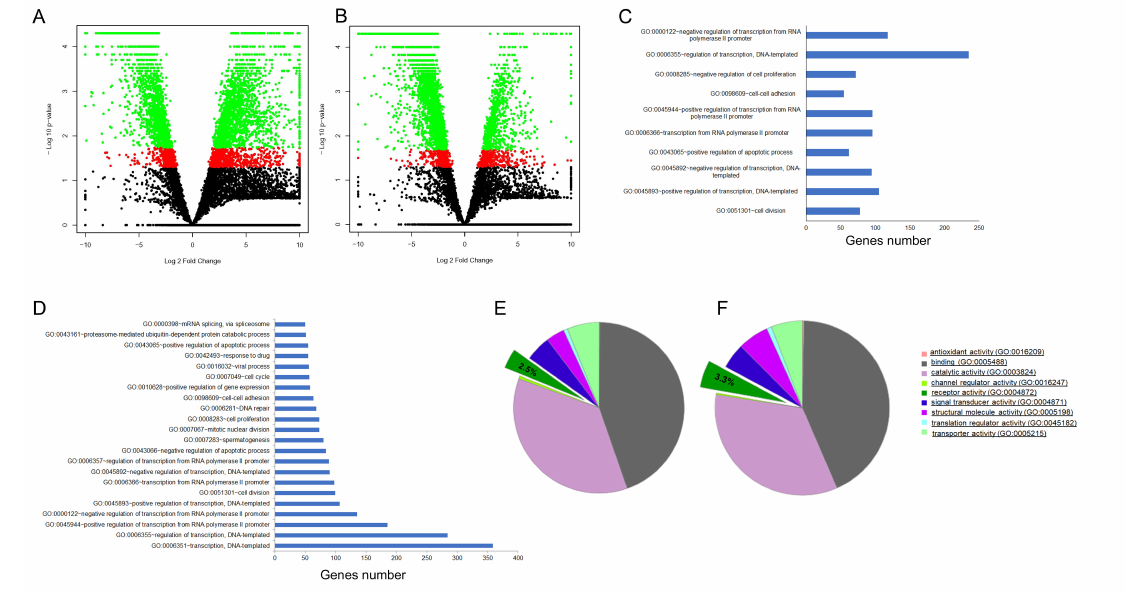
Figure 2. Interplay between oocyte and the surrounding CCs. ( A ) Volcano plot of gene expression changes in oocytes vs. CCs < 35 years. ( B ) Volcano plot of gene expression changes in oocytes vs. CCs ≥ 35 years. ( C ) GO term enrichment analysis of biological processes that were significantly over-represented in oocytes vs. CCs < 35 years. The pathways with the greatest number of annotated genes were related to gene transcription regulation. ( D ) GO term enrichment analysis of biological processes that were significantly over-represented in oocytes vs. CCs ≥ 35 years. The pathways with the greatest number of annotated genes were related to gene transcription regulation, mitotic nuclear division, cell cycle, and DNA repair. ( E ) Classification by molecular function of DEGs in oocytes < 35 years according to PANTHER GO-slim. A total of 2.5% of DEGs (twenty genes) coded for receptors and were significantly more frequently expressed in oocytes < 35 years. ( F ) Classification by molecular function of DEGs in oocytes ≥ 35 years according to PANTHER GO-slim. A total of 3.3% of DEGs (twenty-seven genes) encoded for receptors and were significantly more frequently expressed in oocytes from the ≥ 35 years age